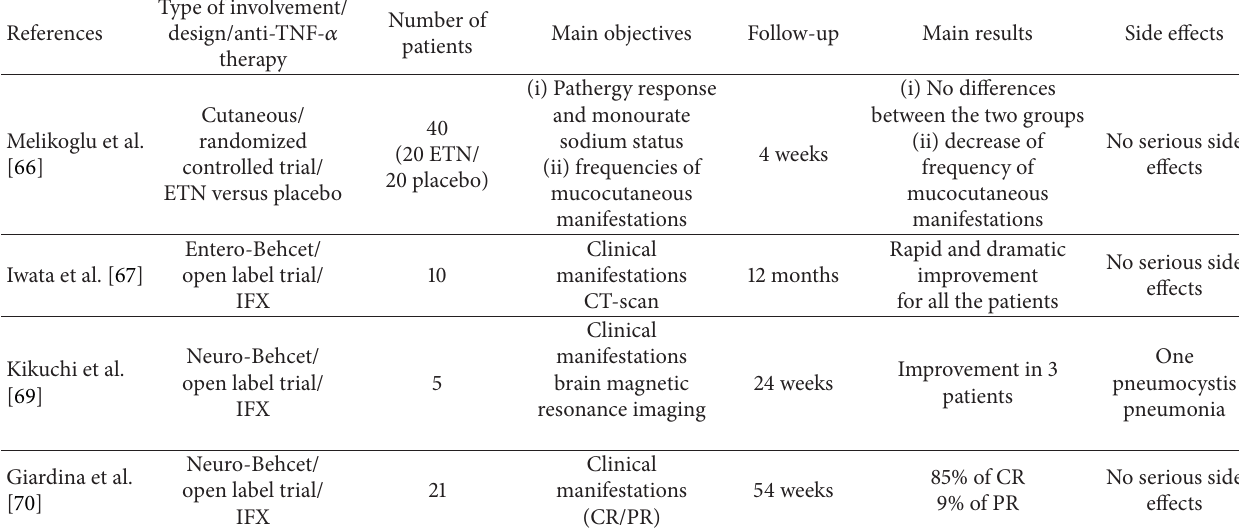
Table 5: Open label and randomized controlled trials performed in BD with cutaneous, intestinal, and central nervous system